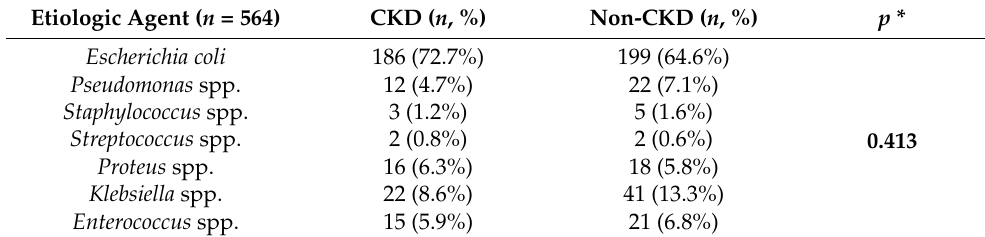
Table 2. Microbial profile of urine cultures according to CKD status.